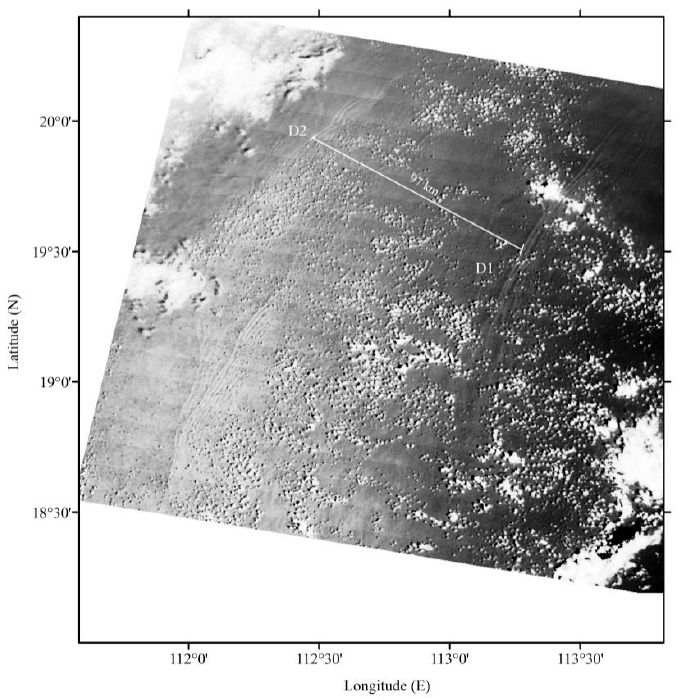
Figure 3. A MODIS image acquired at 03:20:00 UTC on 10 September 2005.